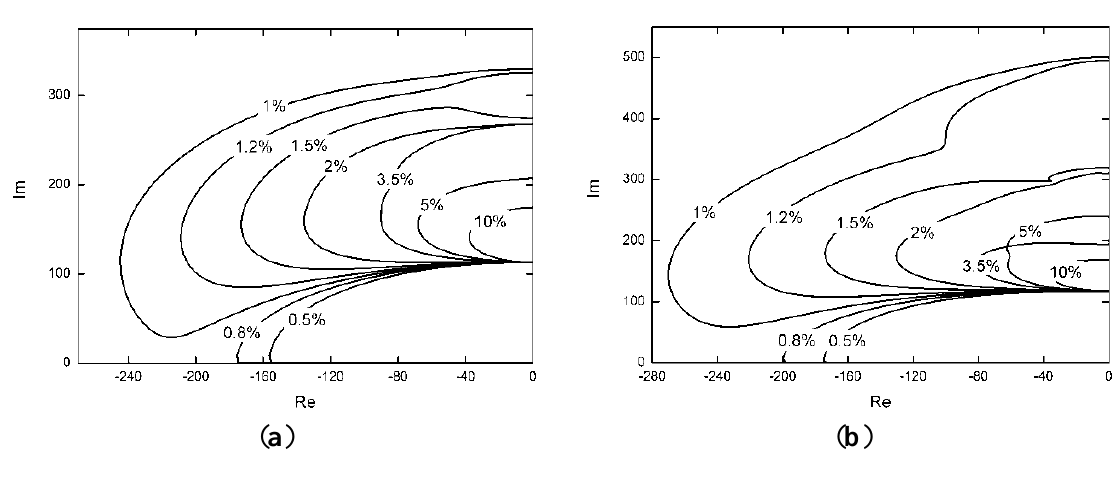
Figure 8. Root locus with different ∆ k